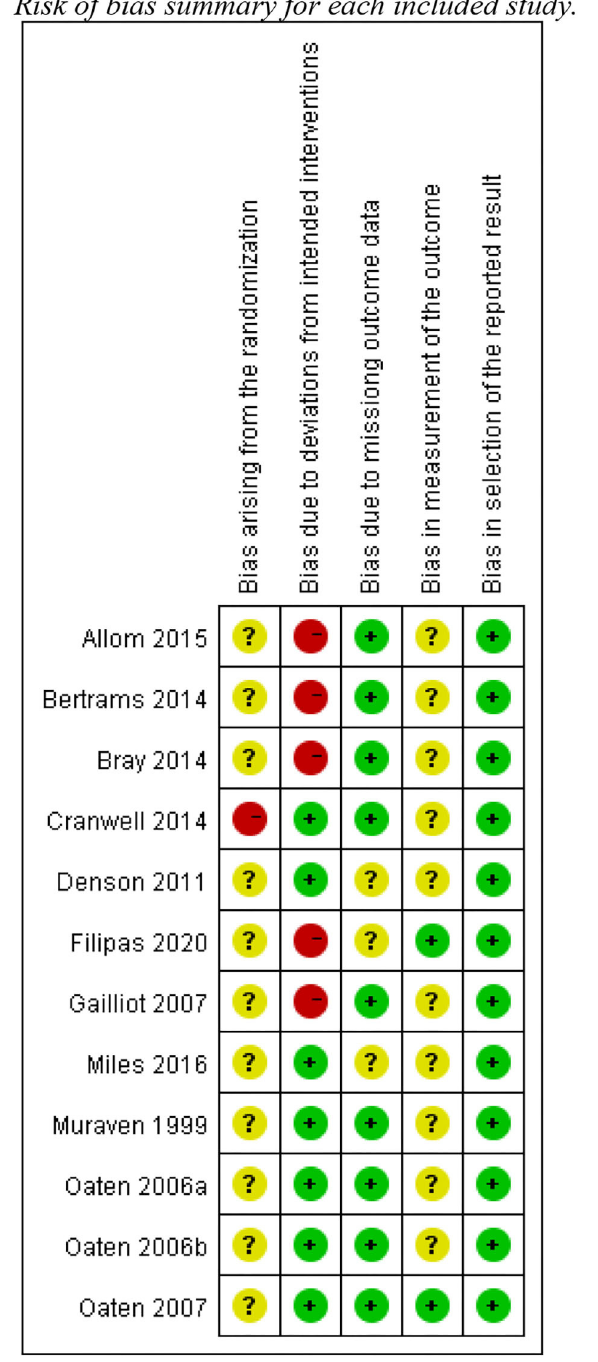
in the Stroop task to 50, and the results showed a significant difference in the reaction time among food-specific ( M = 32.10, SD = 69.64), general ( M = 45.33, SD = 35.21), and no inhibition ( M = 132.45, SD = 35.21) groups. However, consistent